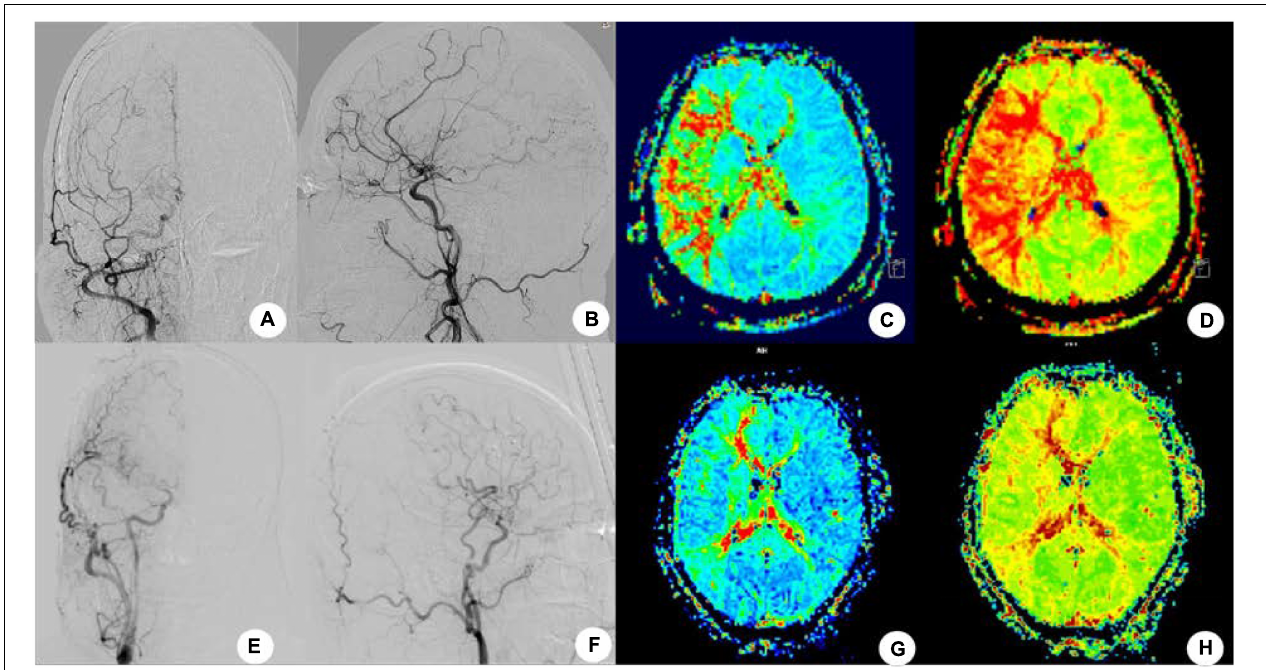
FIGURE 1 | After right superficial temporal artery-middle cerebral artery (STA-MCA) bypass grafting in one patient, no recurrence of stroke and transient ischemic attack was found at 4-month follow-up, and cerebral angiography showed that the bypass supplied blood to the brain. (A,B) Cerebral angiography before the bypass surgery was shown. (C,D) Mean transit time (C) and TTP (D) were shown before surgery in MRI-PWI. (E,F) Cerebral angiography after surgery. (G,H) Four months after surgery, the MTT (G) and TTP (H) were significantly improved.